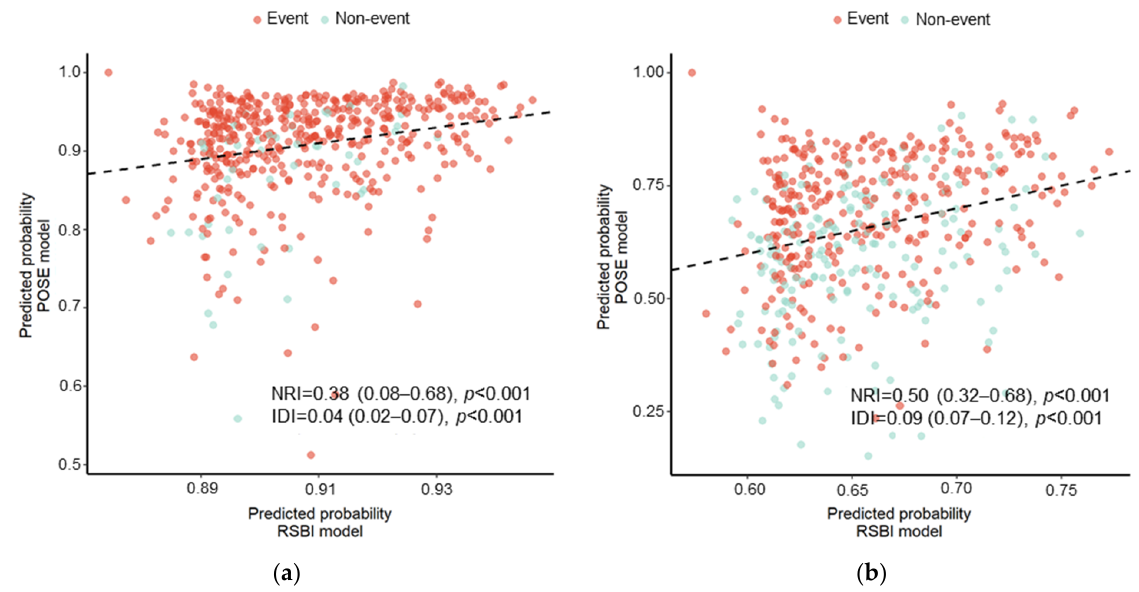
Figure 3. Receiver operating characteristic curves for the prediction models. The receiver operating characteristic curves for successful extubation ( a ) and uneventful extubation ( b ) for models based on eight predefined physiological factors (POSE model) and RSBI alone (RSBI model). The AUCs are shown for each model, and the p -values represent the intergroup differences. POSE, Prediction of Successful Extubation; AUC, area under the receiver operating characteristic curve; RSBI, rapid shallow breathing index.